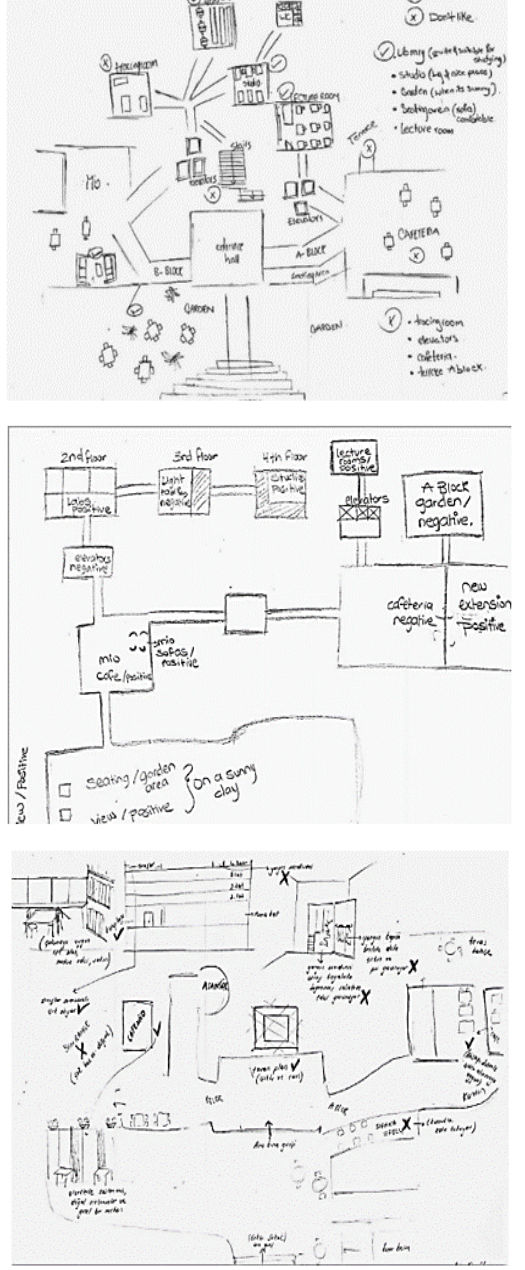
Figure 2. Cognitive map samples of students from their vertical campus experiences: Relational schema (a,b) , Descriptive schema (c)